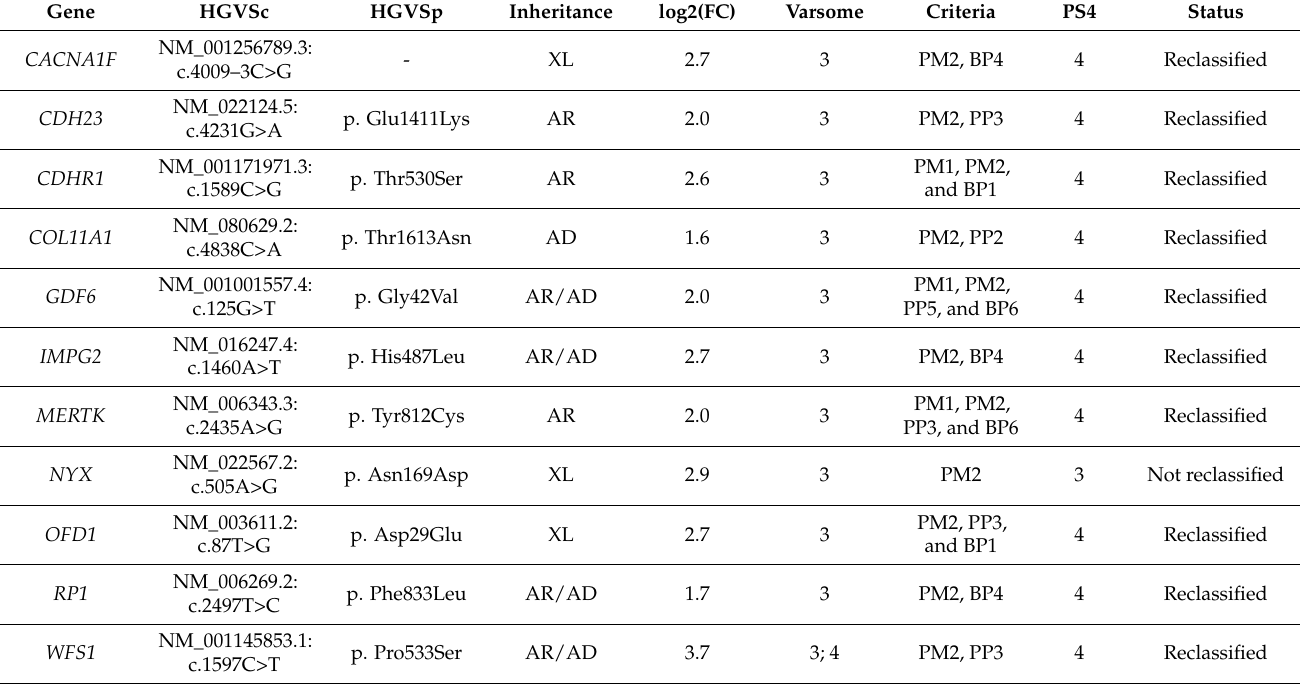
Table 2. Reclassification of VUS, with information added about the difference in their frequency in cases and controls. The ACMG classification of VUS with log2 fold change (FC) higher than 1.5 is reevaluated. Gene code, variants in nucleotide code, and protein code are provided. The inheritance mode is annotated as autosomal recessive (AR), autosomal dominant (AD), and x-linked (XL). In the “Varsome” column, we add the automatic ACMG classification of the variants provided by the Varsome database at the time of writing. Previous ACMG criteria fulfilled by the cases are annotated in the “Criteria” column. Column “PS4” provides the new ACMG classification reached after including PS4 criteria. In column “Status”, reclassified variants are